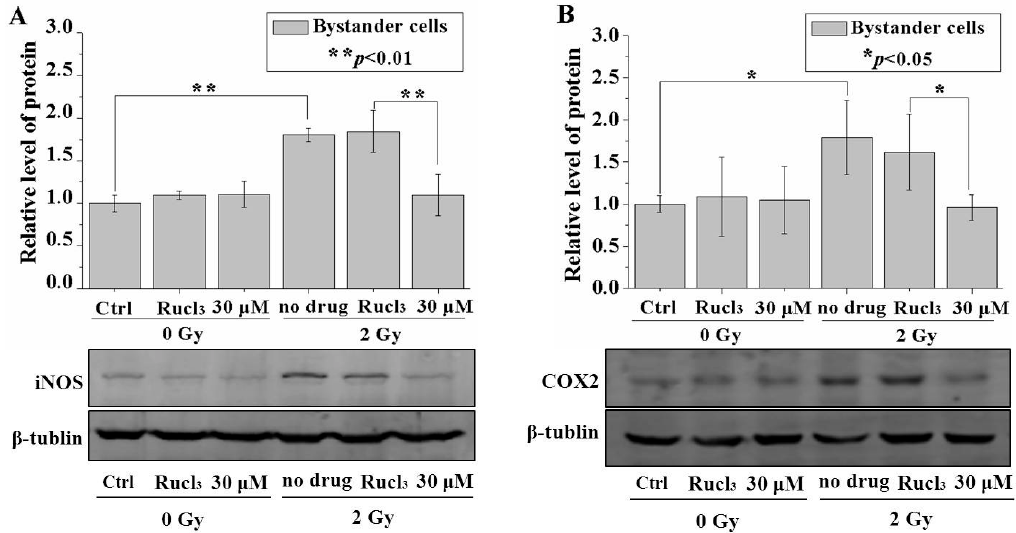
Figure 6. CO decreases the expression of iNOS or COX-2 in the bystander cells. Relative level of iNOS ( A ); and COX-2 ( B ) protein expression in bystander cells with or without CO (CORM-2) treatment. Data are pooled from at least three independent repeats and the results are presented as mean ± SD. Significances in the differences between the samples are determined and differences with p < 0.05 are considered statistically significant.